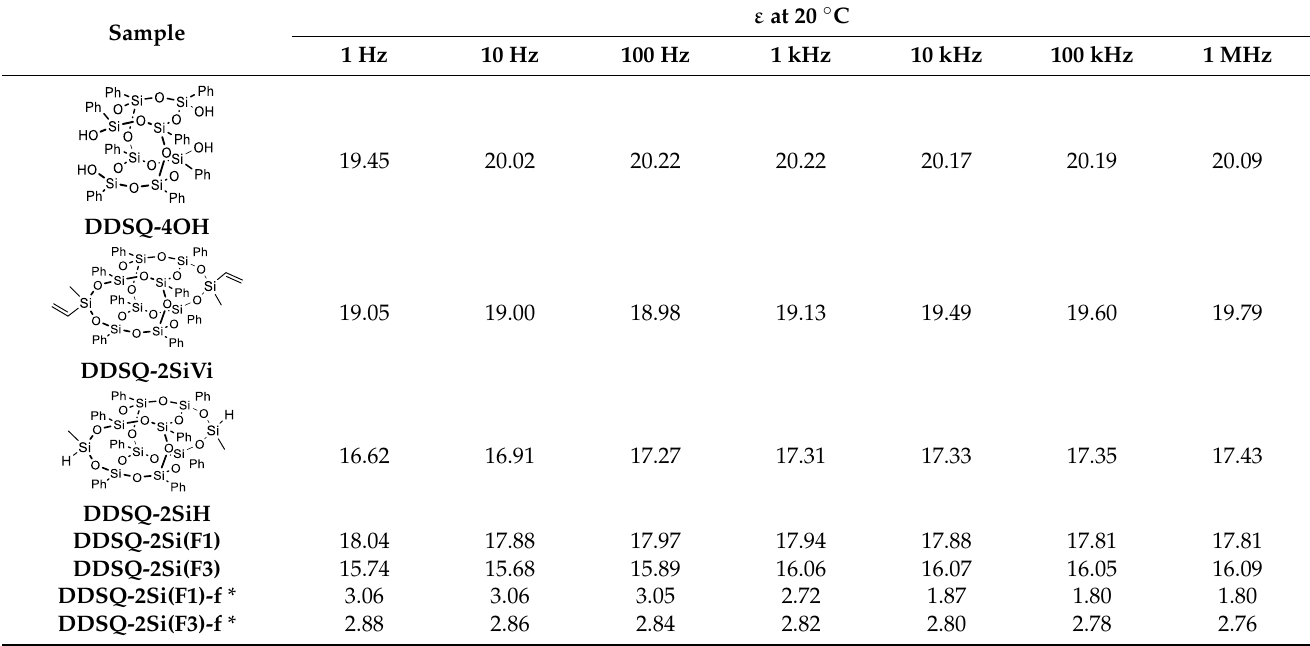
11 of 17 Figure 7. Frequency dependence of dielectric permittivity measured for respective compounds: DDSQ-4OH , DDSQ-2SiVi , DDSQ2Si(F3) , DDSQ-2SiH , DDSQ-2Si(F1) at different temperatures: ( a ) 20 °C (pristine sample, before thermal studies), ( b ) 20 °C (after 300 min, at T = 20 °C), ( c ) −1 00 °C